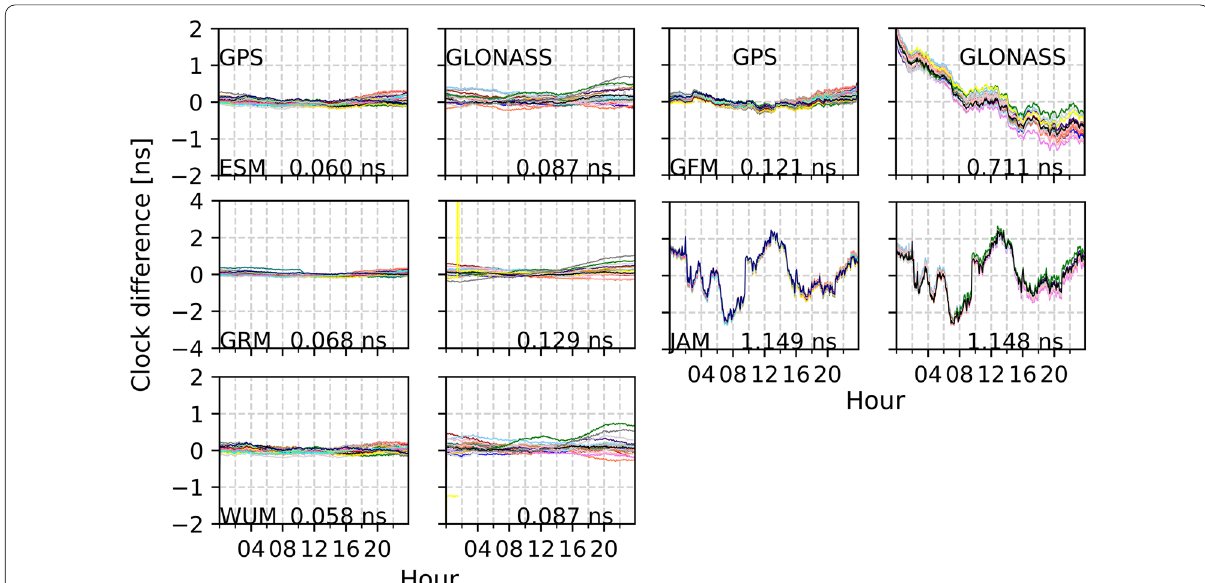
Fig. 4 Clock differences between ESM, GFM, GRM, JAM, WUM and COM for GPS and GLONASS on DOY 001, 2018. Different colors indicate different satellites and the values in black are the mean STDevs for each constellation. The average bias of all satellites is subtracted from GLONASS clock difference for